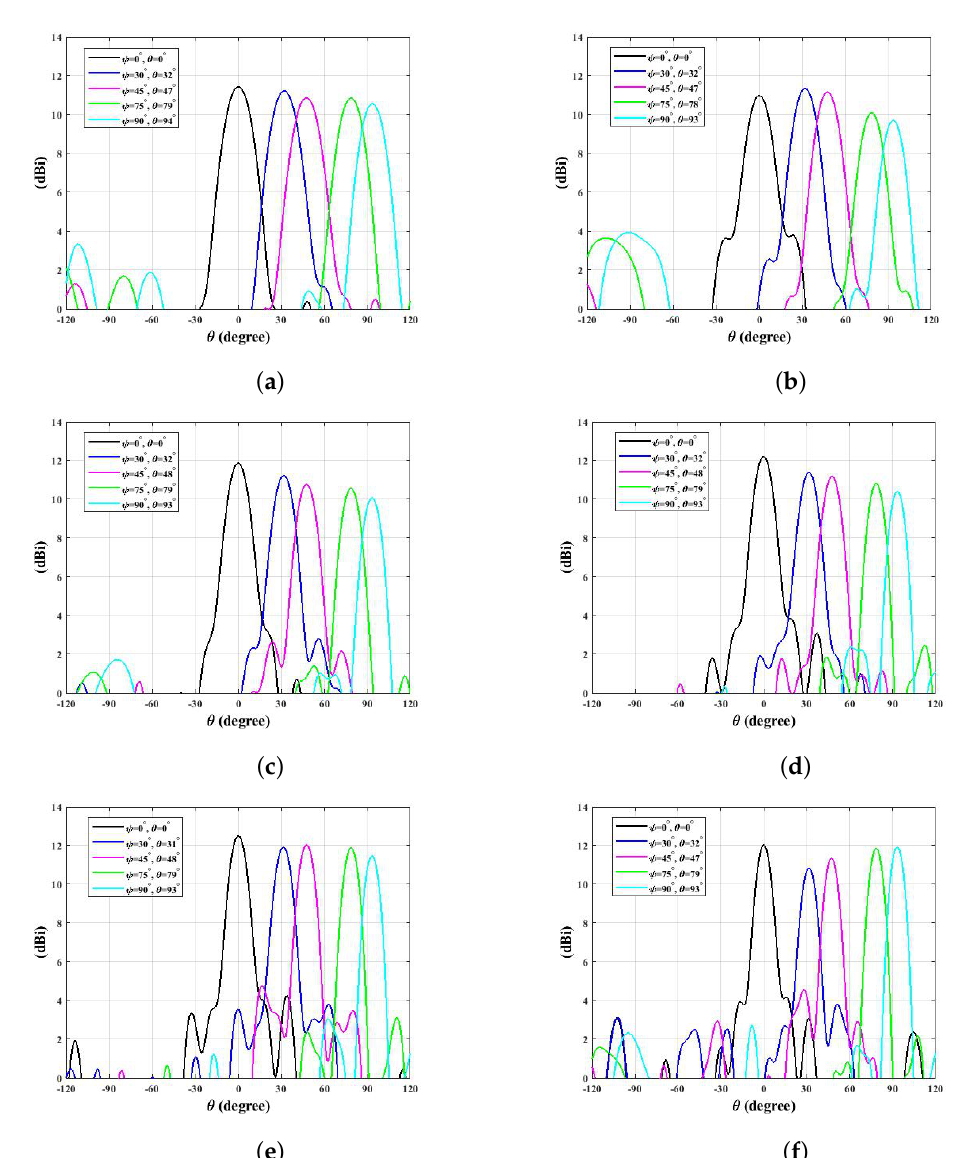
Figure 6. ( a – f ) Simulated steered radiated beam obtained after the placement of cylindrical rods in 10 GHz, 11 GHz, 12 GHz, 13 GHz, 14 GHz and 15 GHz